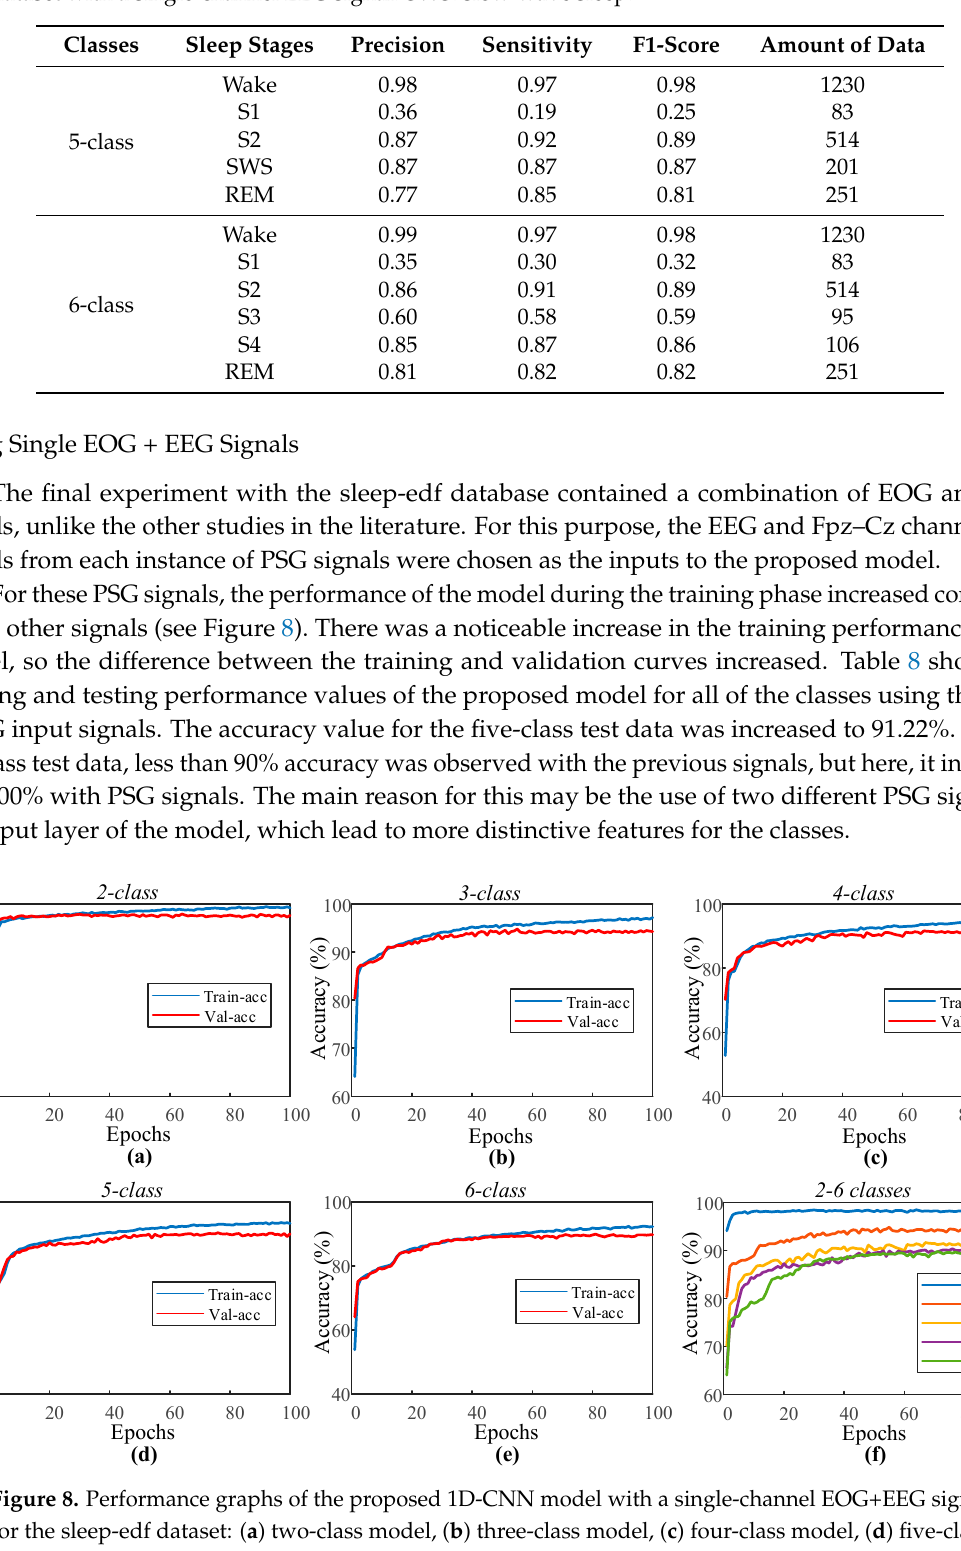
Table 7. The performance values obtained for the five-class and six-class test data using the sleep-edf dataset with a single-channel EEG signal. SWS: slow-wave sleep.